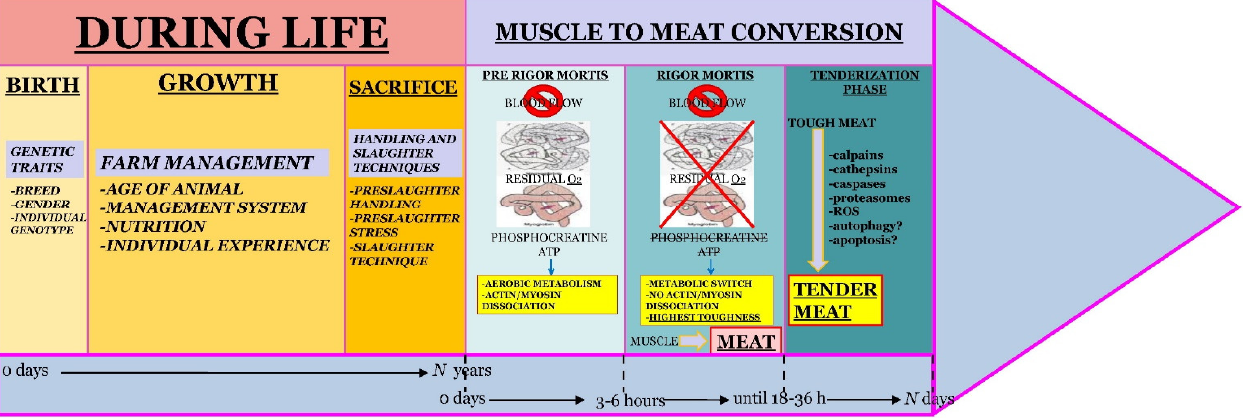
Figure 1. Timeline for development of meat tenderness. [Note: After rigor mortis, in the tenderization phase plant proteases are added to improve the meat tenderization by degrading connective tissue and myofibrillar proteins]. “Reprinted from Ref. [25]. Copyright (2016) with permission from Elsevier”.